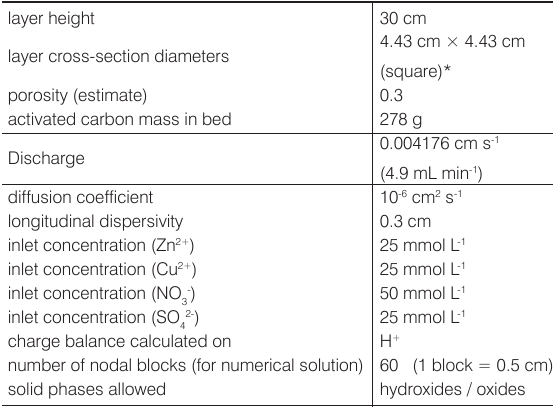
Table 2. Input data for the model calculation of the column experiment.